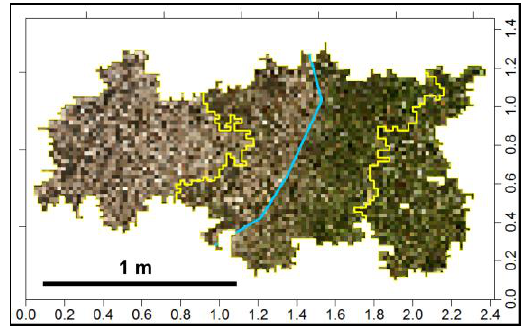
Figure 5: Gradient-like transition from eroded to grass . The segment in the middle (yellow boundaries) covers the transition zone. Thus, classification of this segment will result in error, compared to the manual classification (blue).